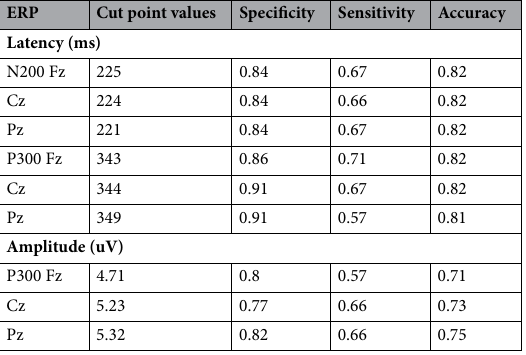
Table 5. Results of ROC analyses for the N200 and P300 ERP components. ERP event-related potential, Fz frontal region, Cz central region, Pz parietal region.